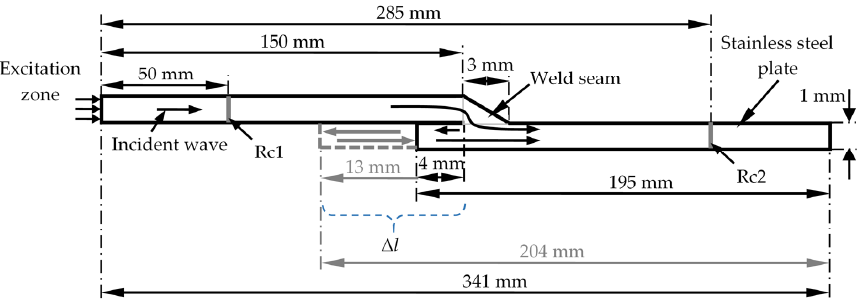
Figure 2. Model used for the investigation of the symmetric S 0 guided wave mode transmission through the different width Δ l lap joint welded plates.